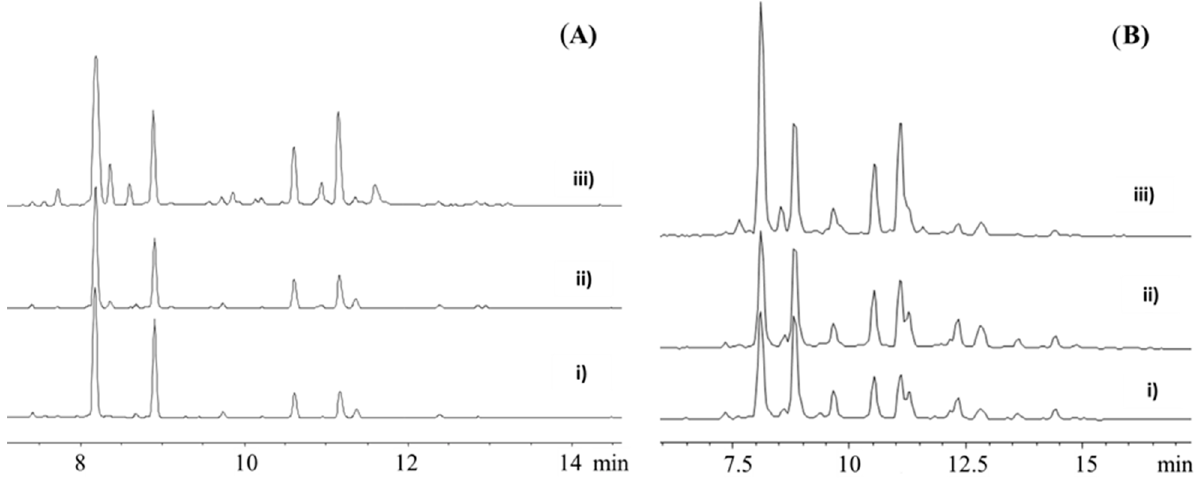
Figure 3. HPLC-DAD-MS analysis of (i) saffron stigmas, (ii) commercial saffron extract (affron ® ) and (iii) gardenia extract; ( A ) DAD signal at 440 nm and ( B ) MS signal corresponding to the extracted ion chromatogram at 329.1747 m/z .